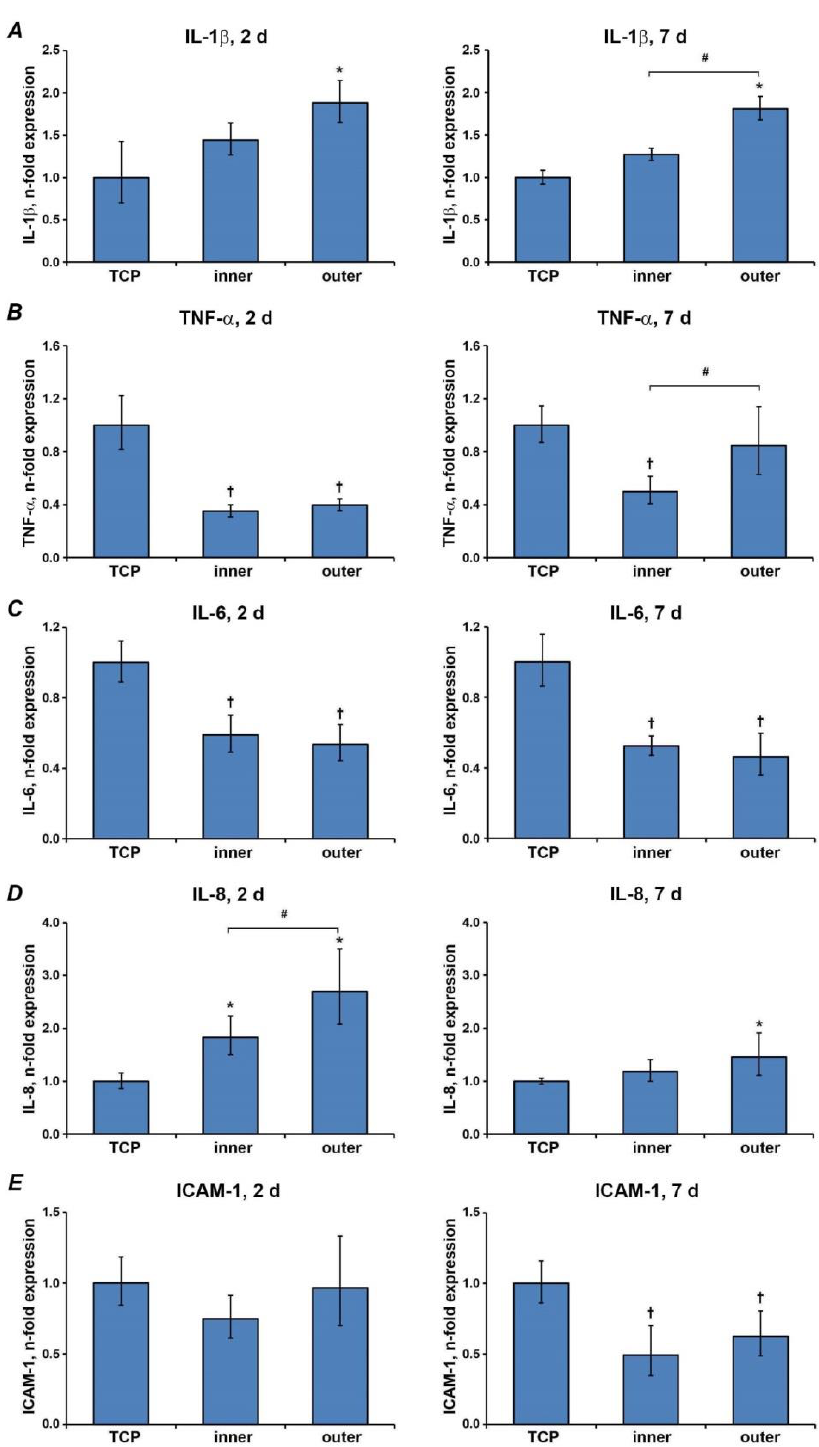
Figure 5. Gene expression of inflammatory markers in HOKs grown on different surfaces. Gene expression of IL-1β ( A ), TNF-α ( B ), IL-6 ( C ), IL-8 ( D ) and ICAM-1 ( E ) after 2 and 7 days in HOKs grown on different aligners’ surfaces and TCP were measured by qPCR. Y-axes represent n-fold expression in relation to HOKs grown on TCP (n-fold expression = 1), which was calculated using the 2 −ΔΔCt method. Data are presented as the mean ± S.E.M. of four independent experiments. *—significantly higher compared to control; †—significantly lower compared to control; #—significantly different between groups; p < 0.05.